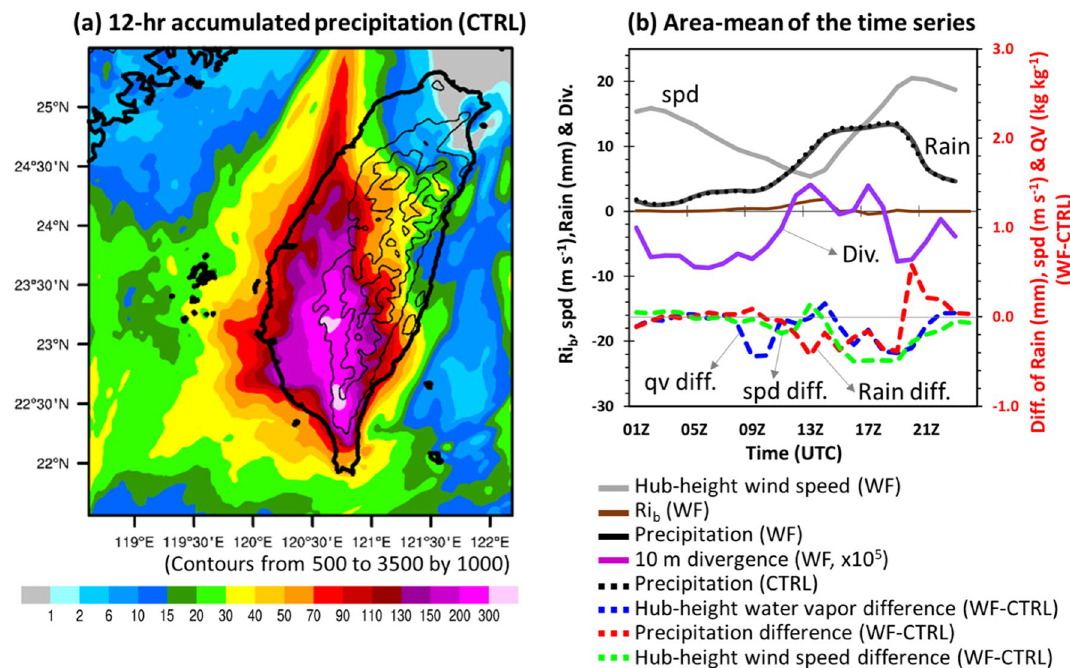
Figure 4. ( a ) 12-h accumulated precipitation (mm) in case CTRL over Taiwan during 12:00–23:00 UTC on July 30, 2017. Contours indicate the terrain height (m). ( b ) Area-mean (22.5–24° N, 119.5–121° E) of the time series of hub-height wind speed in case 356-WTs (denoted by the grey line, m s −1 ), 10-m divergence (purple line, s −1 , left axis) and atmospheric stability (brown line, left axis) calculated from model levels 1 (~ 17 m) and 6 (~ 198 m) close to the rotor disk (28–192 m) in case 356-WTs (23.9–24.2° N, 120.0–120.1° E), and precipitation (black solid line, mm, left axis) of case 356-WTs and CTRL (black dashed line, mm, left axis), and the differences of precipitation (red dashed line, mm, right axis), hub-height wind speed (green dashed line, m s −1 , right axis) and hub-height water vapor (blue dashed line, g kg −1 , right axis) during 01:00–23:00 UTC on July 30, 2017. Maps and plots were produced using NCAR Command Language (NCL) version 6.6.2 37